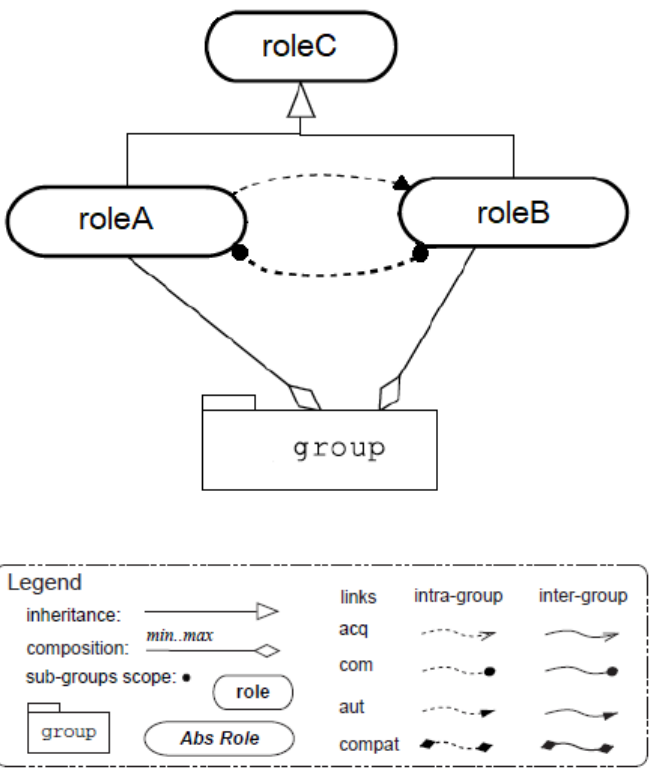
Figure 2. M oise + structural specification, based on